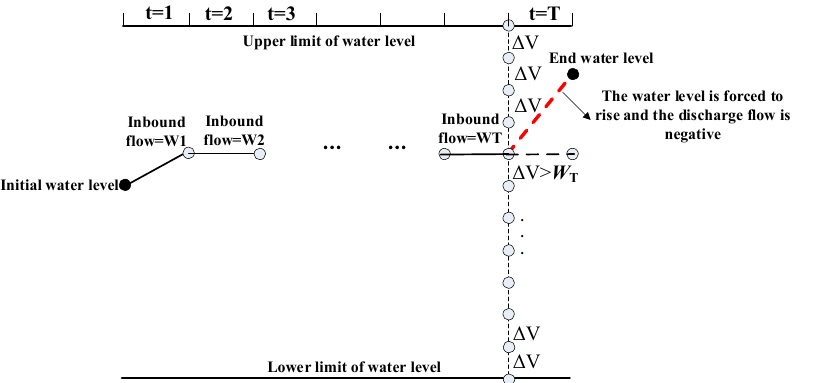
Figure 3. Schematic diagram of the negative value of discharge flow.